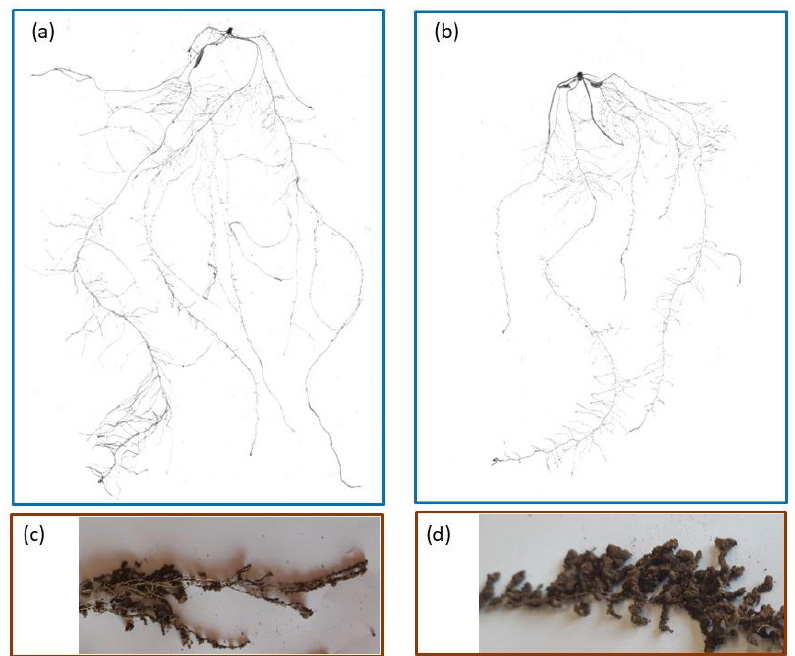
Figure 7. Images of belowground parts of sample plants: ( a ) Scanned image of roots of one sample plant at WW; ( b ) scanned image of roots of one sample plant at DS; ( c ) root with rhizosheath at WW; and ( d ) root with rhizosheath at DS.